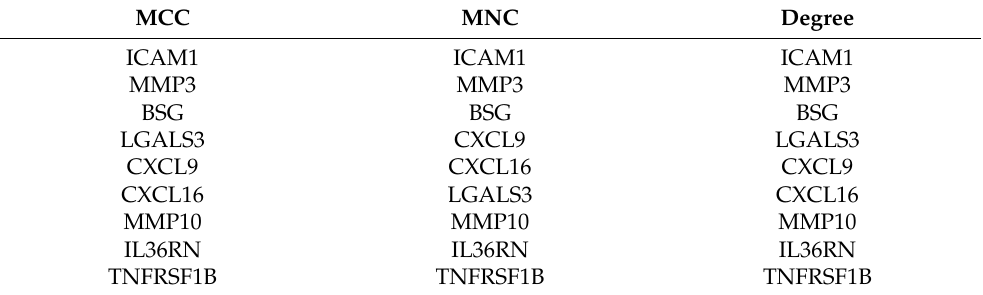
Figure 6. ( A ) The interactions between the 29 differentially expressed proteins between EVs isolated EVs from the Model group and the Icariin-treated group; ( B ) The TF–gene–miRNA interaction network. Table 1. List of the top nine hub genes selected by MCC, MNC and degree methods in CytoHubba.